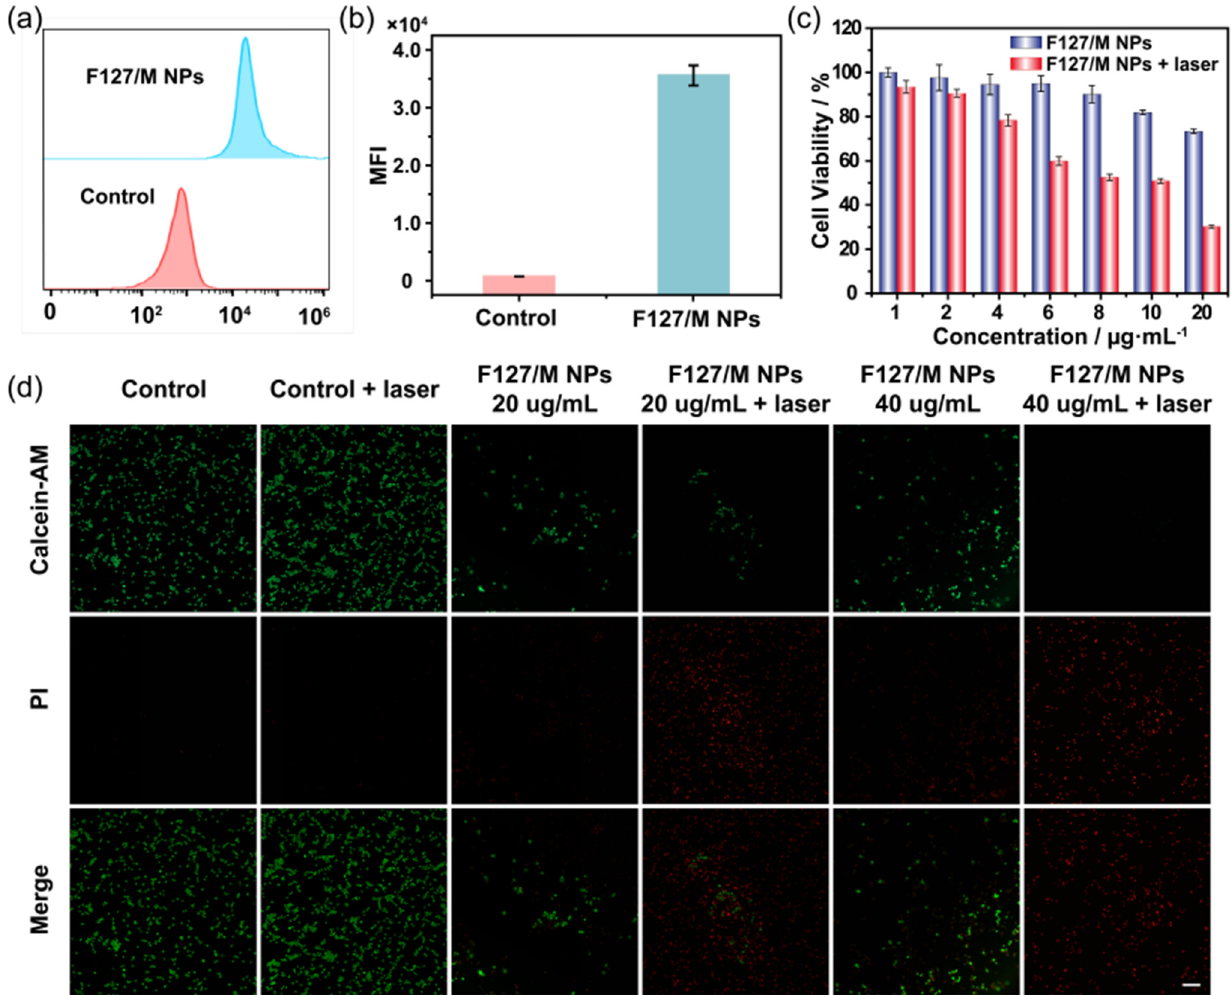
Figure 4. ( a , b ) Flow cytometry of U87 cells incubated with F127/ M NPs. ( c ) Cell viability of U87 cells incubated with F127/ M NPs at different concentrations in darkness and after laser irradiation (660 nm, 1.0 W/cm 2 , 30 s). ( d ) Calcein-AM-/PI-containing fluorescence imaging of U87 cells after different treatments. Laser irradiation: 660 nm, 1.0 W/cm 2 , 5 min. Scale bar: 50 μ m.